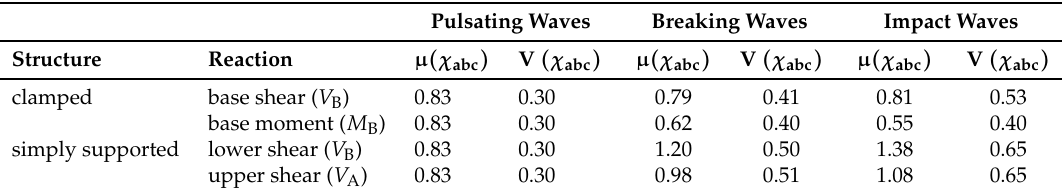
Table 5. Mean and coefficient of variation of the total model uncertainties in GT wave load formula caused by (a) knowledge uncertainties, (b) deliberate simplifications, and (c) differences in dynamic behavior between slender hydraulic structures and caisson